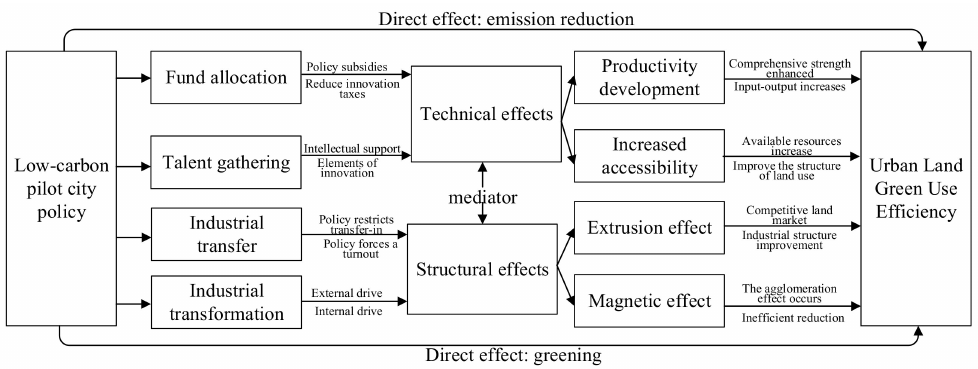
Figure 1. Analysis of impact mechanism of low-carbon pilot policy on